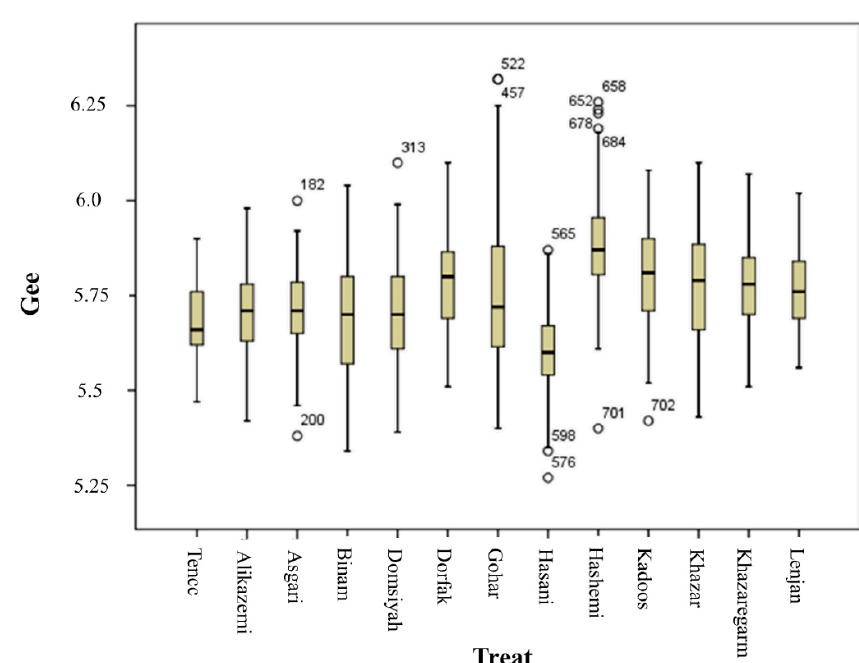
Figure 5. The box plot of red band entropy for 13 paddy cultivars.